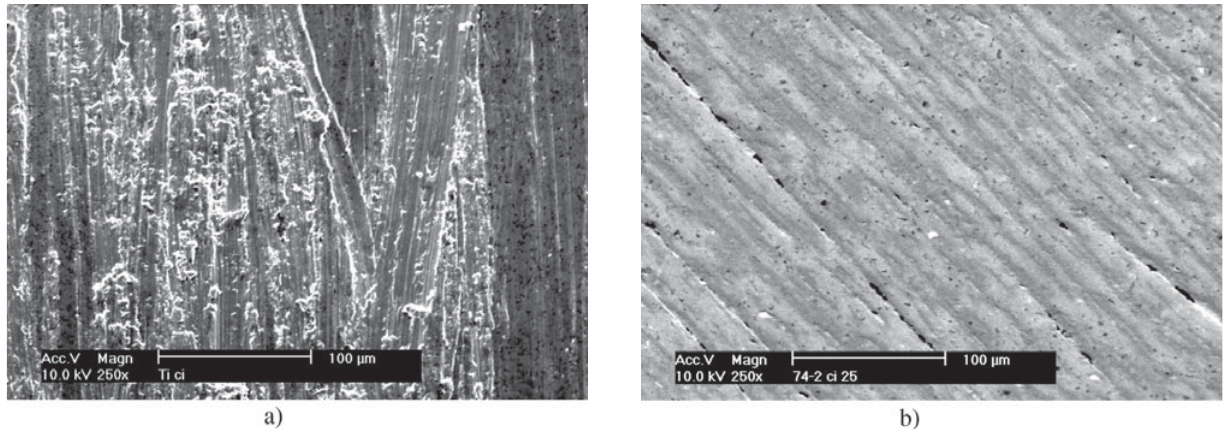
Figure 3. SEM photomicrographs under 250× magnification after test with Gracey scaler in (a) c.p. Ti; (b) nitrided